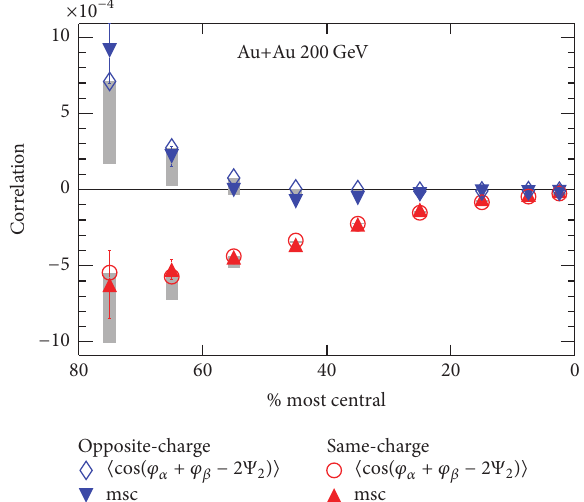
Figure 6: Modulated sign correlations (msc) compared to the three- point correlator versus centrality for Au+Au collisions at √𝑠 NN = 200 GeV [45]. The gray bars reflect the conditions of Δ𝑝 𝑇 > 0.15 GeV/ 𝑐 and Δ𝜂 > 0.15 applied to 𝛾